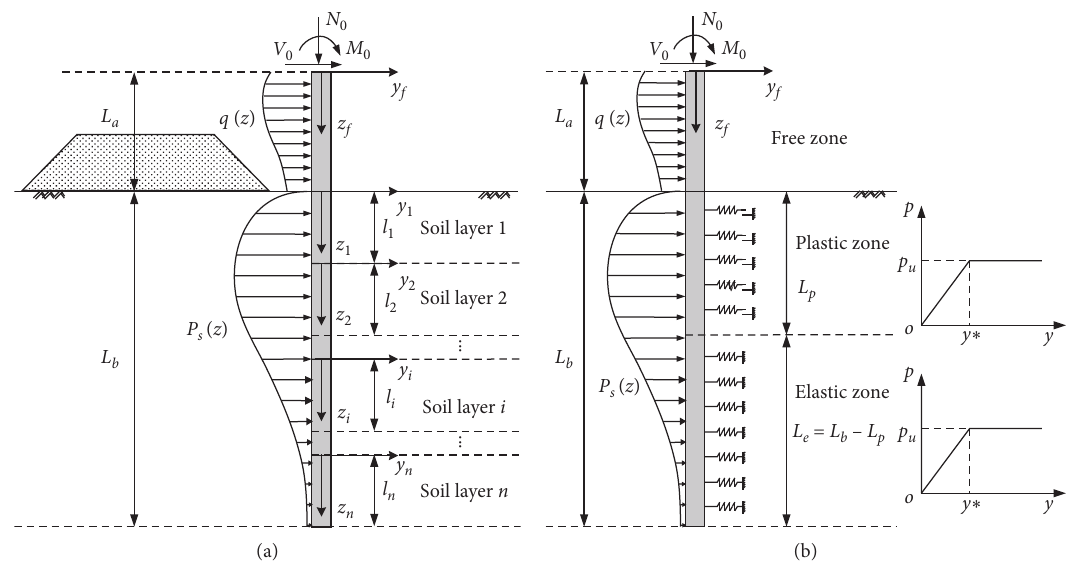
Figure 1: Pile subjected to both active and passive loading. (a) Problem statement. (b) Free, plastic, and elastic